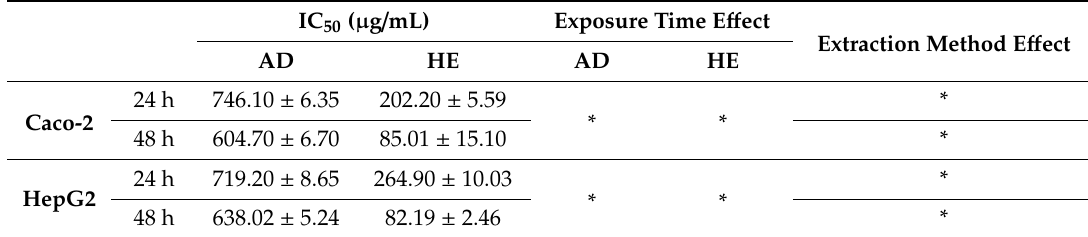
Figure 3. Anti-proliferative e ff ect of Thymus zygis subsp. zygis aqueous decoction (AD) and hydroethanolic (HE) extracts on Caco-2 ( A and B for AD and HE extracts, respectively) and HepG2 cells ( C and D for AD and HE extracts, respectively). Two exposure times, 24 and 48 h, were considered, as indicated. Results are expressed as (mean ± SD, n = 4). Statistically significant di ff erences ( p < 0.05) between the control and sample concentrations at respective incubation time are denoted by *, and those between exposure periods at the same concentration are denoted by #. Table 3. E ff ect Thymus zygis subsp. zygis extracts on Caco-2 and HepG2 cells, expressed as IC 50 values. Cells were exposed to aqueous decoction (AD) and hydroethanolic